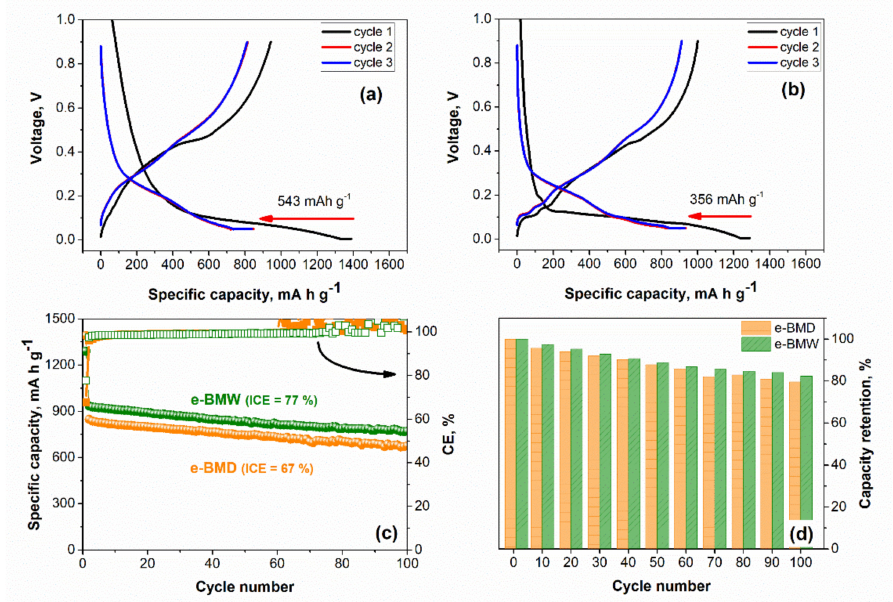
Figure 5. Discharge—charge curves from cycle 1 to 3 of ( a ) e-BMD and ( b ) e-BMW. The irreversible capacity of the first cycle is shown. ( c ) Coulombic e ffi ciency (CE) (squares) and specific capacity (spheres) vs. cycle number of e-BMD (orange) and e-BMW (green). The initial coulombic e ffi ciency (ICE) is shown. ( d ) Capacity retention of e-BMD (orange) and e-BMW (green). The voltage window is 0.05–0.9 V and the current density is 250 mA / g. First activation cycle: 0.005—0.9 V at 100 mA /